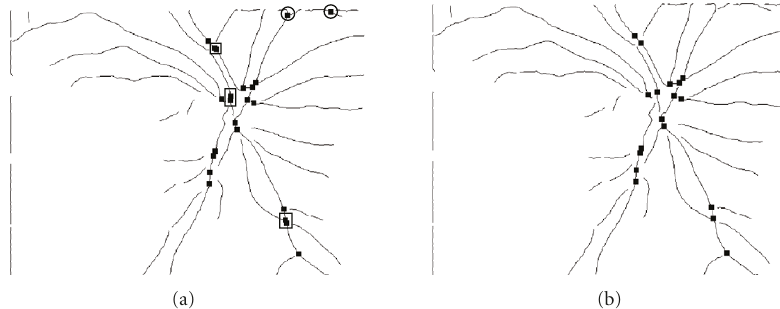
Figure 8: Example of the result after the feature points filtering. (a) Image containing feature points before filtering. (b) Image containing feature points after filtering. Spurious points from image borders and duplicate crossover points have been eliminated.